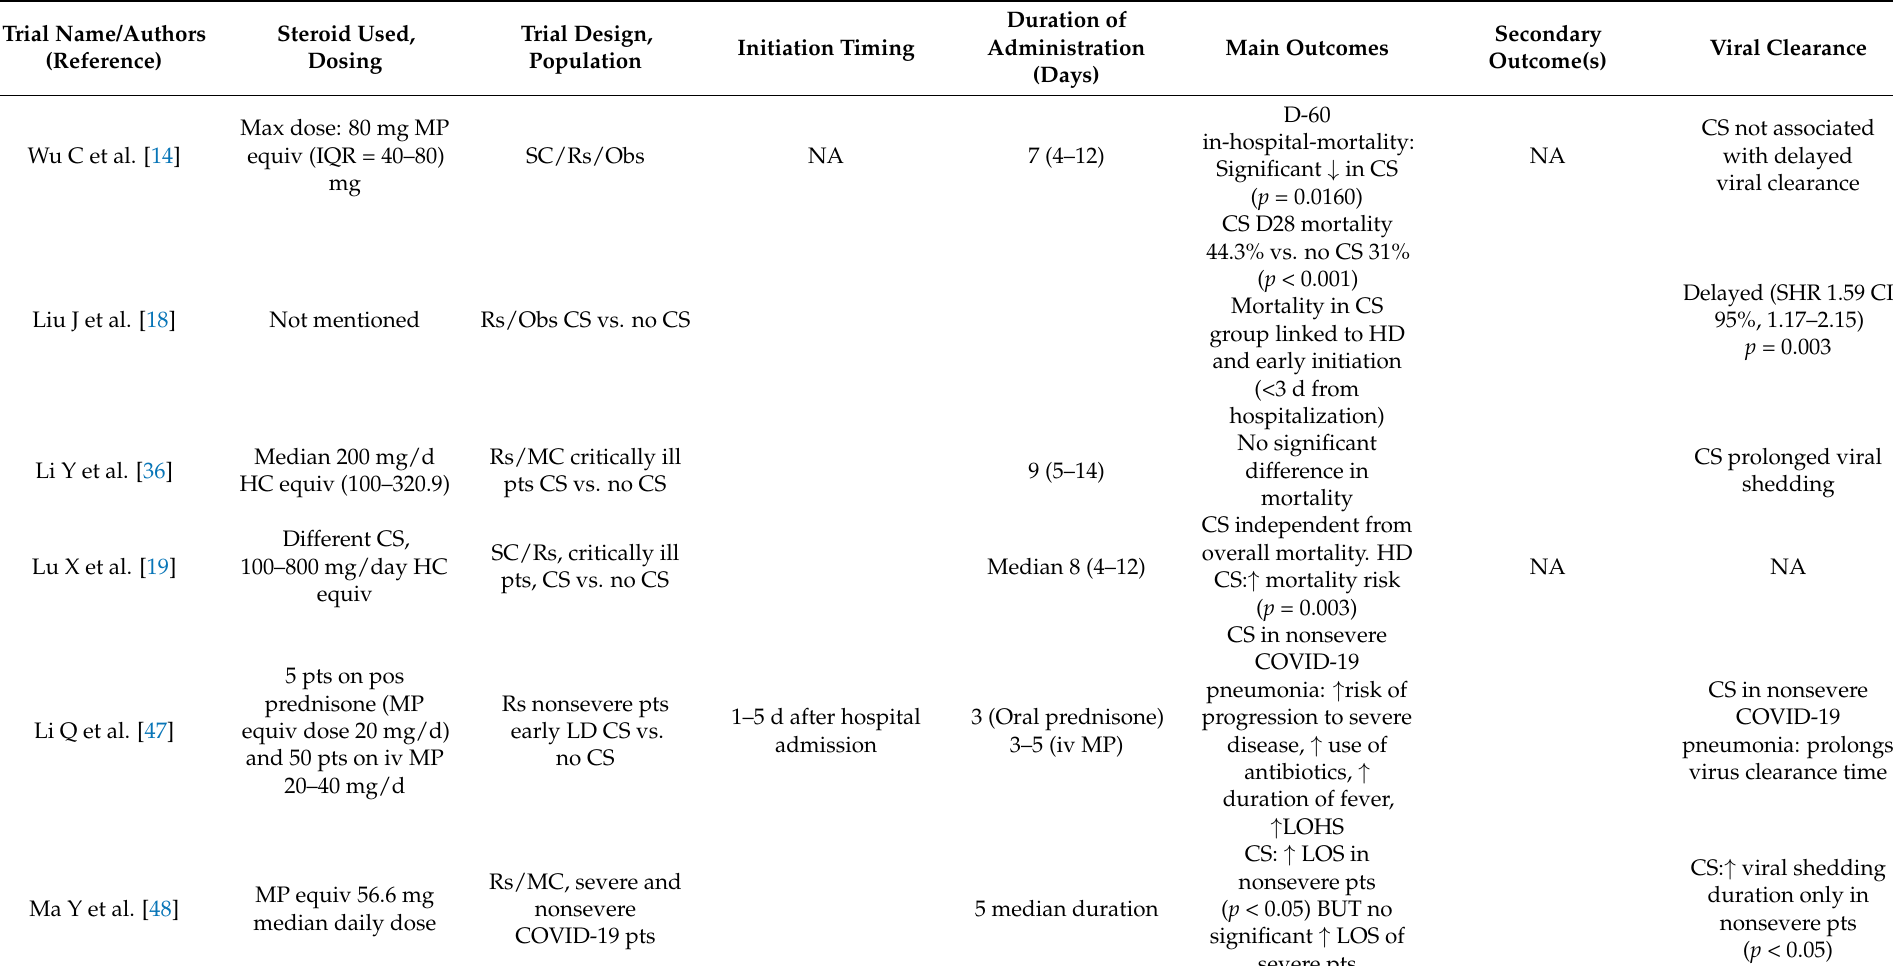
Table 4. Trials using different corticosteroids (CS); design (Rs = retrospective and obs = observational and As = ambispective in yellow and MA = meta-analysis and SRMA = Systematic Review and Meta-analysis in orange), timing, duration, outcomes (focusing on mortality data), and viral